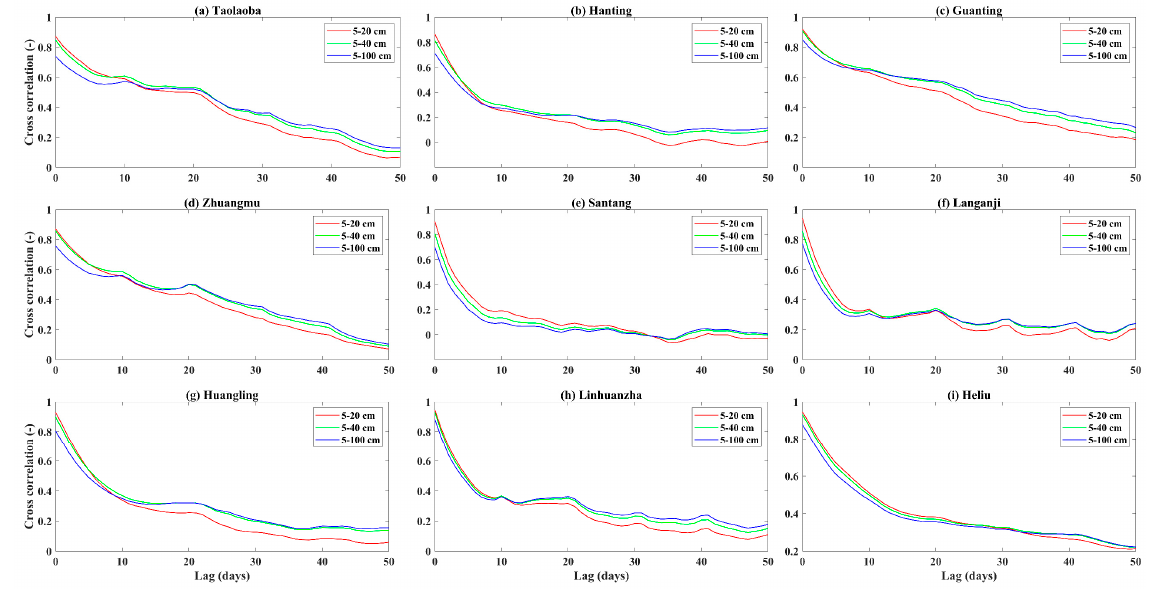
Figure 3. Cross correlation coefficients of soil moisture between near-surface (5 cm) and selected root zone depths (20, 40 and 100 cm) varying with lag time (from 0 to 50 days) at sample stations ( a – i ).